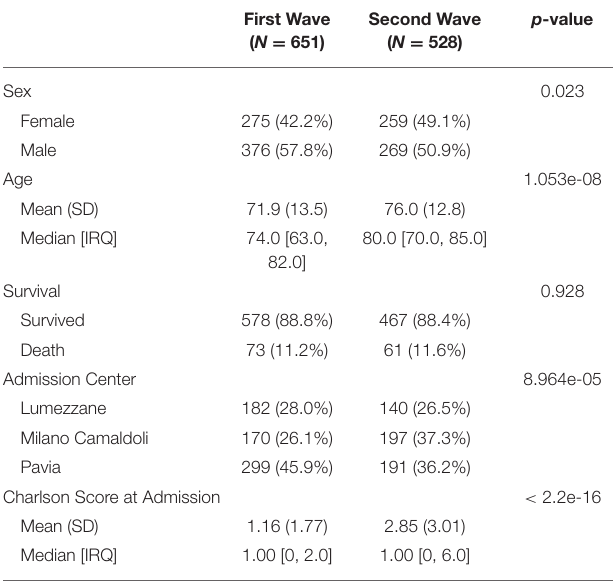
TABLE 1 | Population distribution in